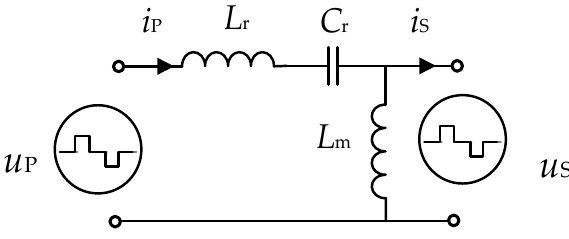
Figure 2. Equivalent model of an LLC ‐ DAB DC ‐ DC converter. In addition, all drive signals of DAB are square wave signals with a 50% duty cycle, and the signals of the upper and lower two switching tubes of each bridge arm are comple- mentary. There are two control variables in the DPS modulation, which are d 1 and d . The corresponding dT is the phase shift time between the symmetry axes of u P and u S , and d 1 T is the phase shift time between the drive signals S 1 and S 4 . Figure 3 shows the switching sequences of each switch and the voltage waveforms of each side of the LLC-DAB converter with DPS modulation, where u P and u S are both three-level AC square wave voltages with the same